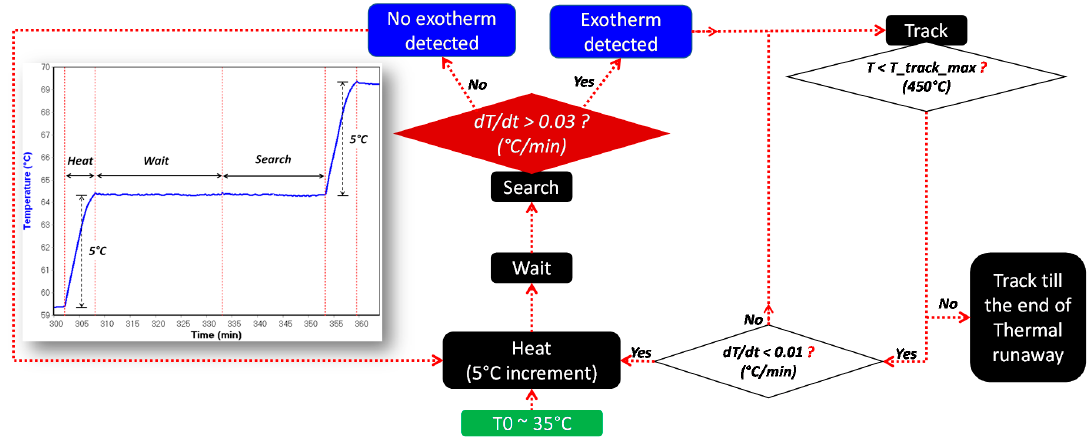
Figure 4. The applied HWS test protocol in quasi-adiabatic conditions.